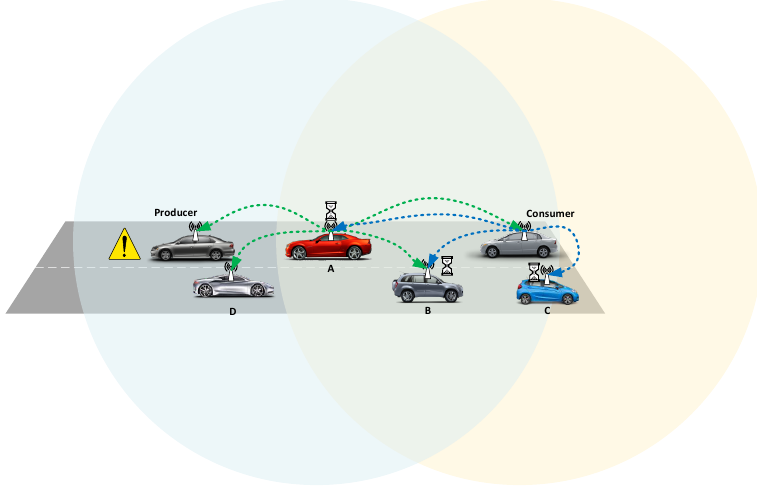
Figure 1. Deferred